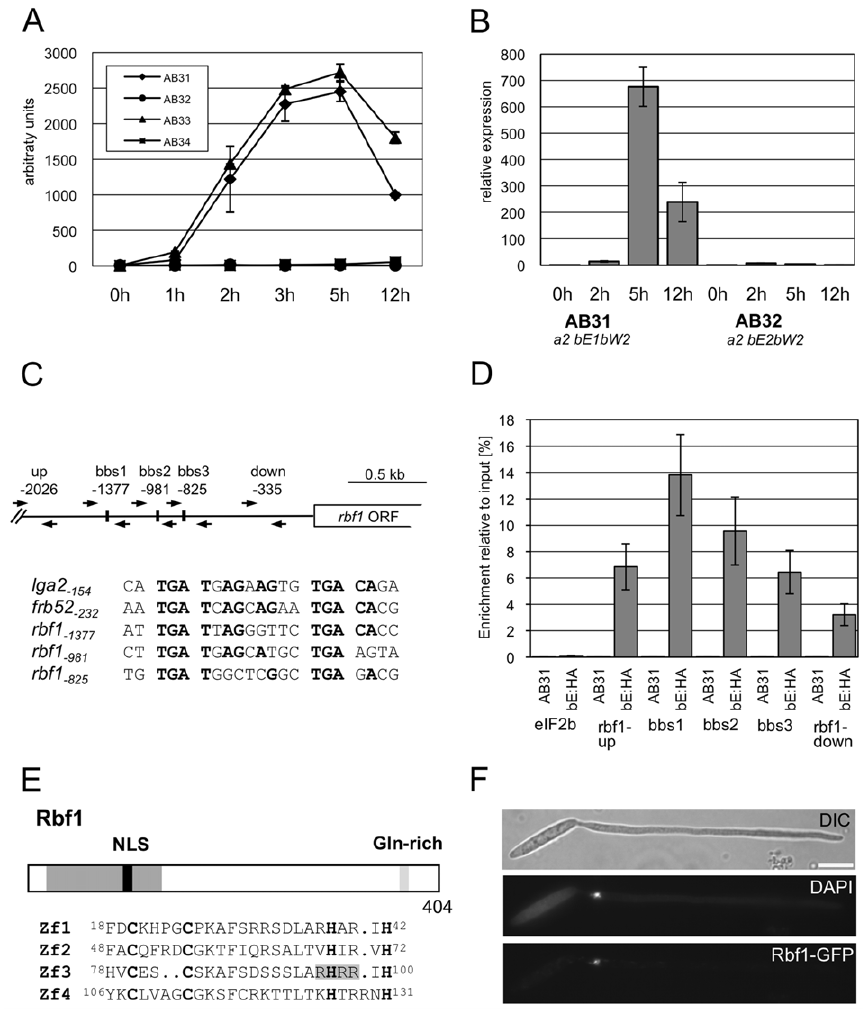
Figure 2. Structure and expression of Rbf1. ( A ) Microarray analysis of b -dependent rbf1 expression after induction of compatible (AB31 and AB33) and incompatible (AB32 and AB34) combinations of bE and bW . Shown are the mean expression values of two biological replicates and the standard deviation (SD) ( B ) qRT-PCR analysis of rbf1 expression after induction of compatible (AB31) and incompatible (AB32) combinations of bE and bW . Samples were taken at the time-points indicated. qRT-PCR analysis was performed using the constitutively expressed ppi gene ( um03726 ) for normalization. Expression was calculated relative to the lowest expression value. Shown are mean values of two technical replicates. ( C ) Overview of primer binding sites in the rbf1 -promoter used for qChIP experiments and alignment of three putative b-binding sites ( bbs ) in the rbf1 promoter region to the bbs of lga2 and frb52 [10,11]. Nucleotide positions indicated are relative to the start codon. Nucleotides identical to the bbs in lga2 [10] and frb52 [11] are in bold. ( D ) qChIP analysis of bE1 binding to the rbf1 -promoter in strains AB31 and AB31bE1:3xHA 5h after induction of the bE1/ bW2-heterodimer. AB31bE1:3xHA harbours a HA-tagged bE1 protein used for immunoprecipitation with anti-HA-antibody. Numbers give the enrichment in % of the input-DNA of the PCR amplicons in DNA co-immunoprecipitated with HA-antibody. No significant enrichment was observed in control strain AB31. In AB31bE1:3xHA, the PCR-amplicon spanning bbs1 (bbs 2 1377 ) is significantly enriched (t-test) when compared to the amplicon spanning a control region ( 2 2026) (p=5.71 10 2 5 ). As additional control, a region from the eIF2b gene ( um04869 ) was used. Given are the mean values of three technical replicates of three independent experiments each, and the standard deviation (SD). ( E ) Structure of the Rbf1 protein. The potential C2H2 zinc finger domain (aa 18 to 131) and a putative NLS (RHRR) (aa 95 to 98) within this domain are marked in dark grey and black, a glutamine rich sequence (aa 365 to 373) is marked in grey. The alignment shows the four C2H2 zinc finger domains; the conserved cysteine and histidine residues are in bold. ( F ) Subcellular localization of the Rbf1-3xeGFP fusion protein. Strain AB31 rbf1:3eGFP (UMS63) was induced in CM medium supplemented with 1% arabinose (CMA) for eight hours. The functional Rbf1-3xeGFP fusion protein localizes to the nucleus. Cells were stained with DAPI to visualize nuclei. Scale bar corresponds to 10 m